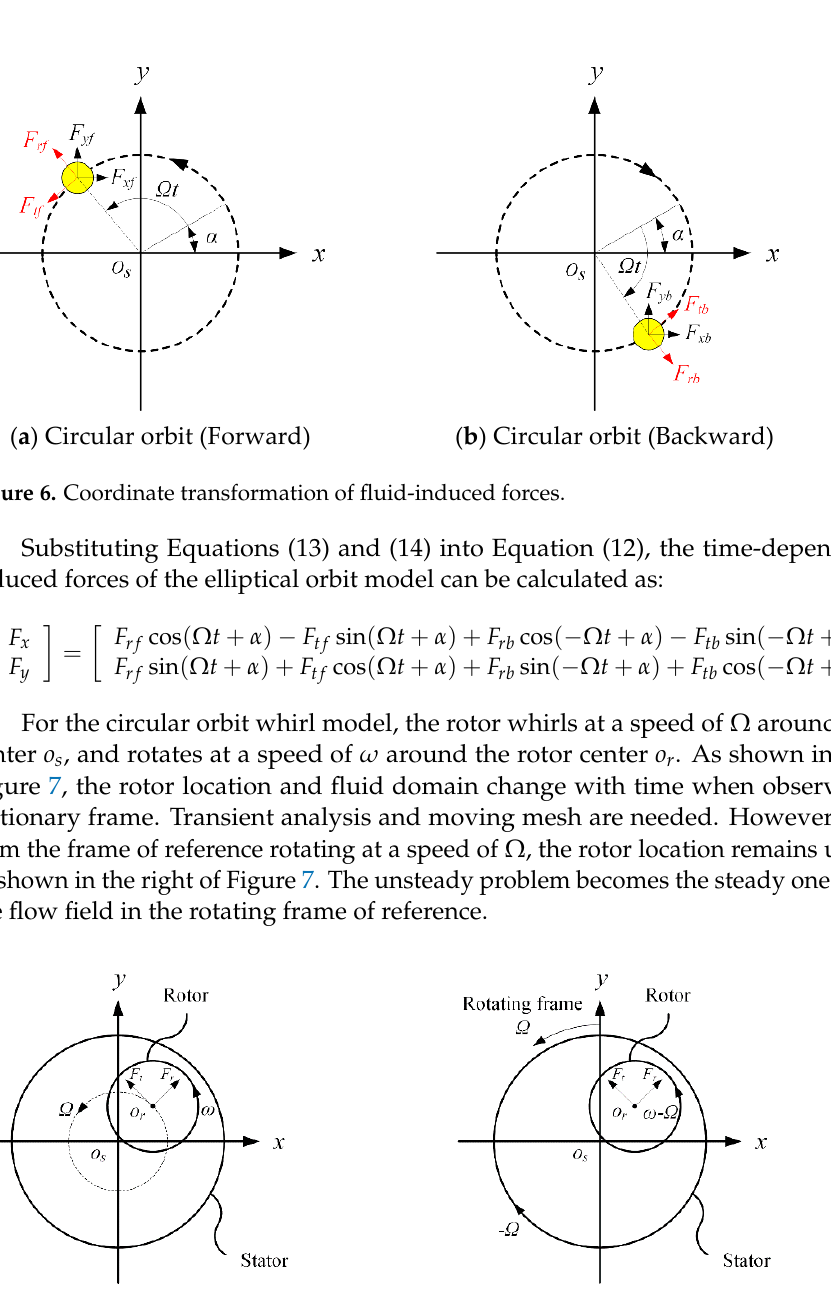
Figure 7. Schematic diagram of steady method.